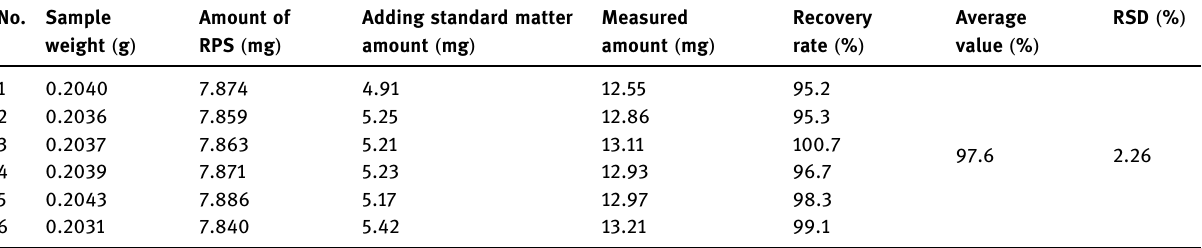
Table 1: Recovery experiment result for polysaccharide determination of B. rynchopetera extract No.